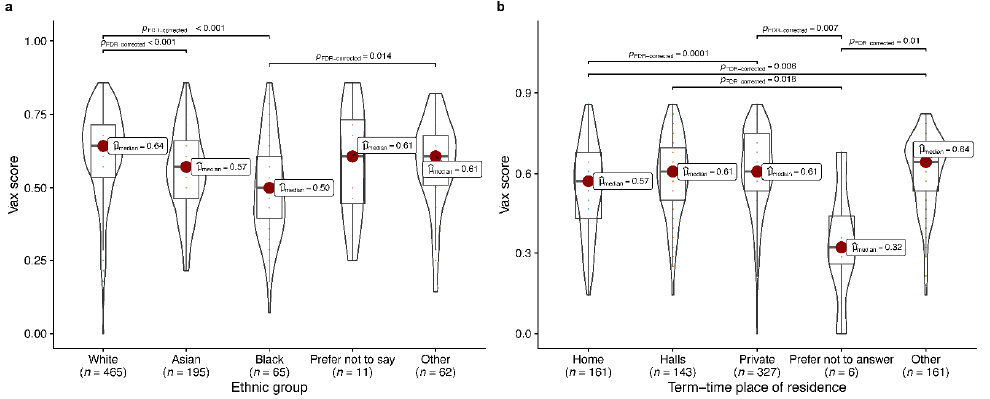
Figure 1. VAX scores for a range of ethnic groups and study residences. The VAX score was determined for each student from responses to four statements about vaccines (statements 17.1, 17.2, 17.3 and 17.5 in Question 17; see Table S1 and Figure S2). VAX scores range from 0 to 1 representing high to low vaccine hesitancy. The VAX scores were determined for all individuals in four broad ethnic groups ( a ) or places of residence during the university term ( b ). Graphs show violin plots with the median scores indicated by a red circle. Box, IQR; line, IQR + 1.5 times IQR; line within box, median. p -values were derived using pairwise Dunn tests with FDR correction.